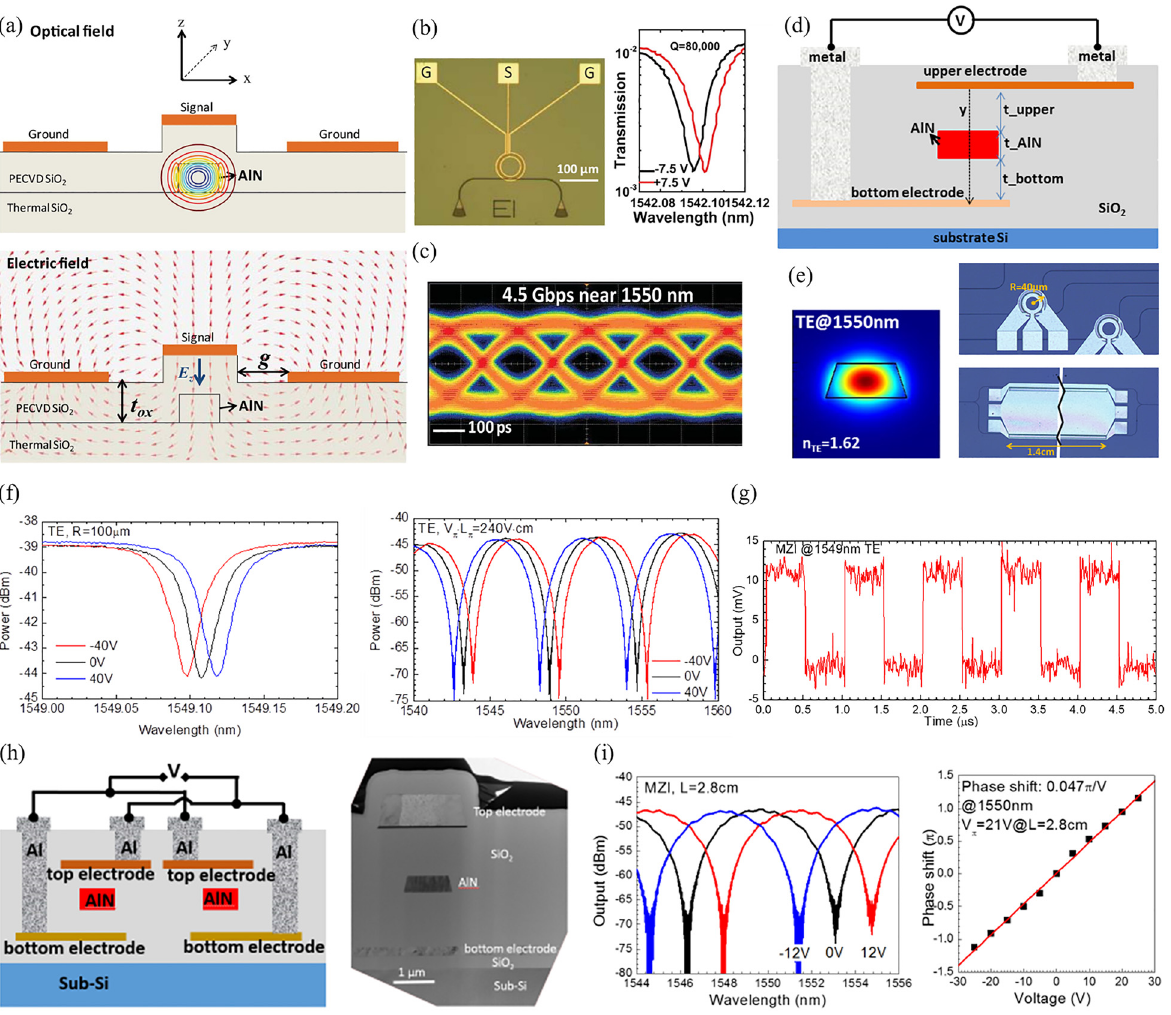
Figure 9: AlN-based integrated optical modulator using Pockels effect. (a) Top panel: simulated optical field intensity distribution (TE mode) in designed AlN waveguide at telecom wavelength. Bottom panel: simulated electrical field distribution at the cross section of designed modulator. (b) Left panel: microscopic image of the fabricated AlN microring with metal contacts and vertical couplers for light coupling onto and out of the device. Right panel: optical resonance around 1542nmwith Q valueof8 × 10 4 ,showingwavelengthshiftsby8pminducedbyapplyingbiasvoltagefrom − 7.5Vto + 7.5V.(c)Cleareyepattern generated using the optical modulator under modulation speed of 4.5 Gbps at 1550 nm. (a) – (c) Adapted with permission from [91], copyright (2012) American Chemical Society. (d) Schematic of AlN-based phase shifter cross section for optical modulator. (e) Left panel: simulated TE modepro fi leat1550nm.Righttopandbottompanel:opticalimagesoffabricatedmodulatorwithmicroringandMZIstructure,respectively.(f) Left and right panel: transmission spectra of microring-based and MZI-based modulator (TE mode), respectively. (g) MZI modulator output waveformat 1549 nm TE mode. (d) – (g) Adapted with permissionfrom [92] © The Optical Society.(h) Left panel:schematic of AlN-basedphase shifter cross section with push-pull structure. Right panel: cross-sectional TEM image of one arm in MZI optical modulator. (i) Left panel: opticalspectraunderdifferentbias voltagesonMZImodulator.Rightpanel:phaseshiftwithrespectto voltageat 1550nm.(h)and(i)Adapted with permission from [75] © The Optical